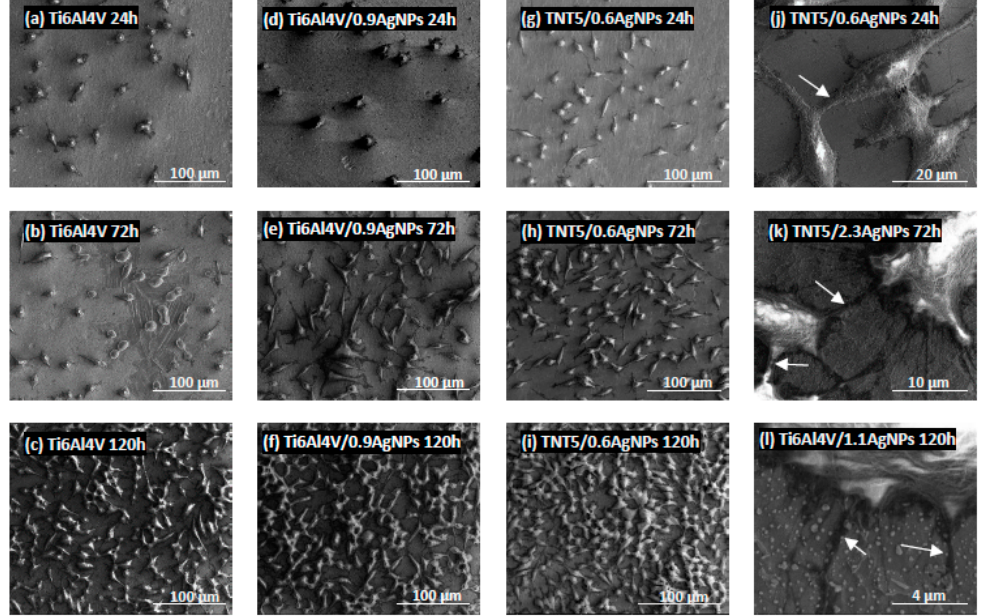
Figure 10. The scanning electron microscopy (SEM) images presenting adhesion (after 24 h) and proliferation (after 72 h and 120 h) of the murine L929 fibroblasts growing on the surface of reference Ti6Al4V alloy foils ( a – c ), (Ti6Al4V/0.9AgNPs) ( d – f ) or Ti6Al4V/TNT5/0.6AgNPs ( g – i ). Arrows in the micrographs indicate numerous filopodia spreading between the fibroblasts ( j – k ) or filopodia, which attached the cells to the surface of nanocoatings ( l ).